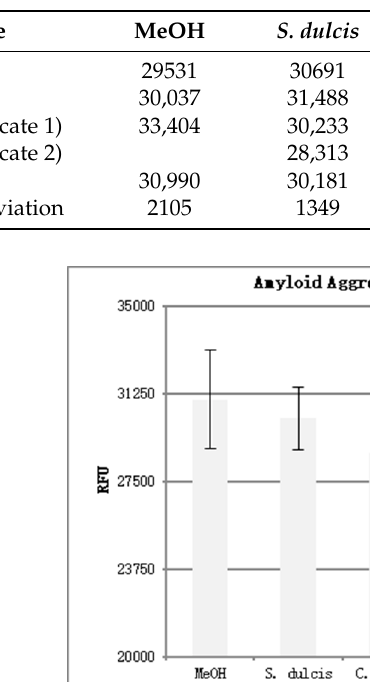
Table 4. Amyloid aggregation assay raw fluorescence data and calculated values.